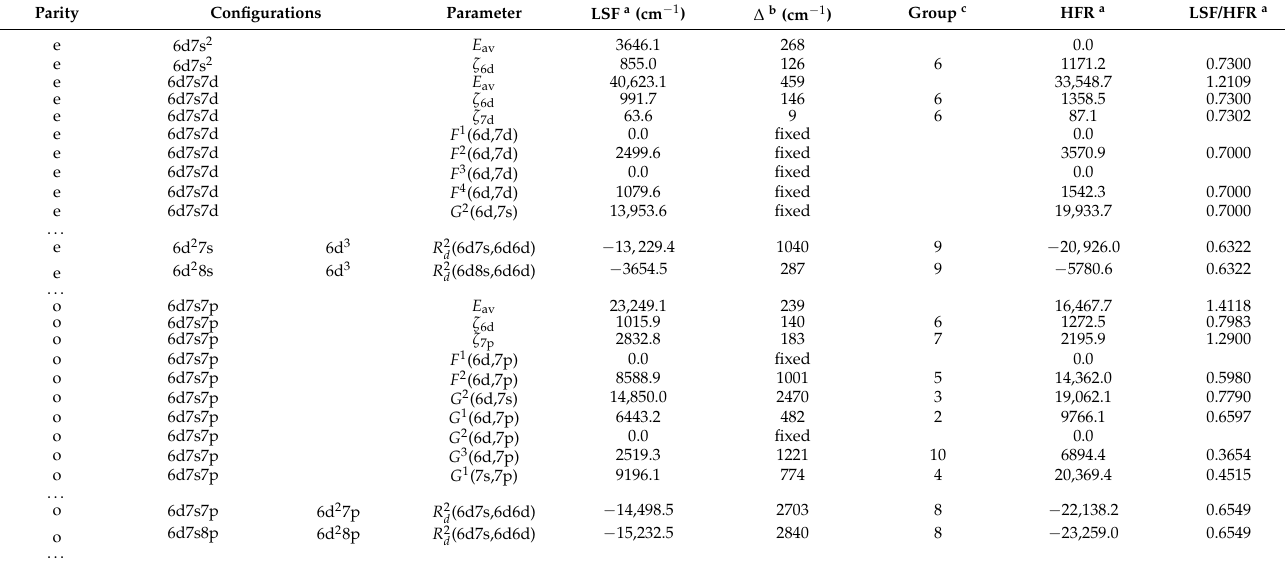
Table 3. Parameters of the least-squares fit for Ac I.